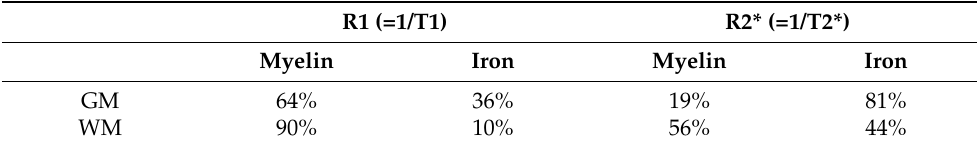
Table 1. Myelin and Iron contributions to R1 and R2* MRI contrast in GM and WM [2]. R1 (=1/T1) R2* (=1/T2*) Myelin Iron Myelin Iron GM 64% 36% 19% 81% WM 90% 10% 56%